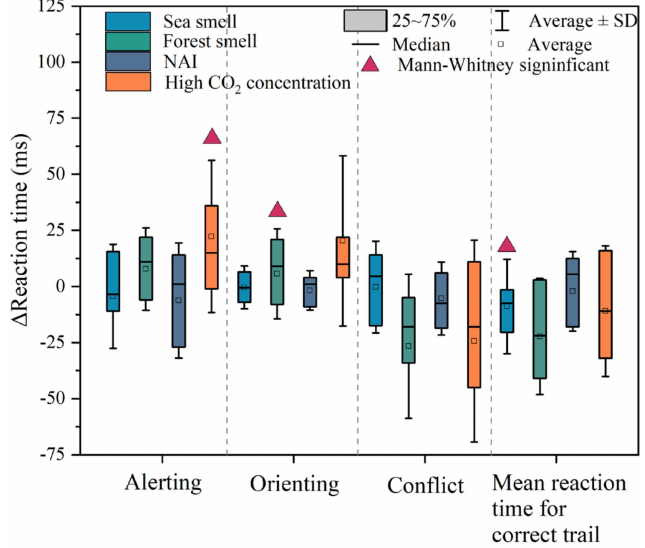
Figure 10. The ANT results in the four